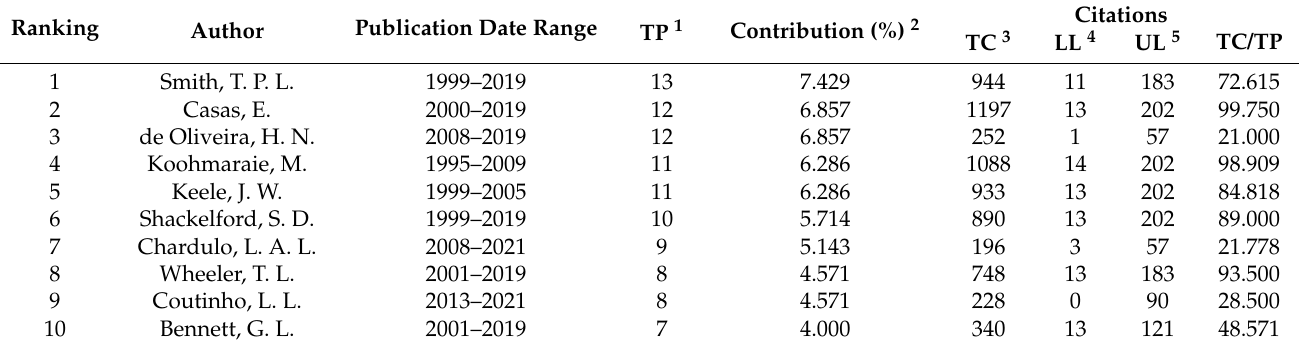
Table 1. Authors with more participation in research on the role of genetics in meat